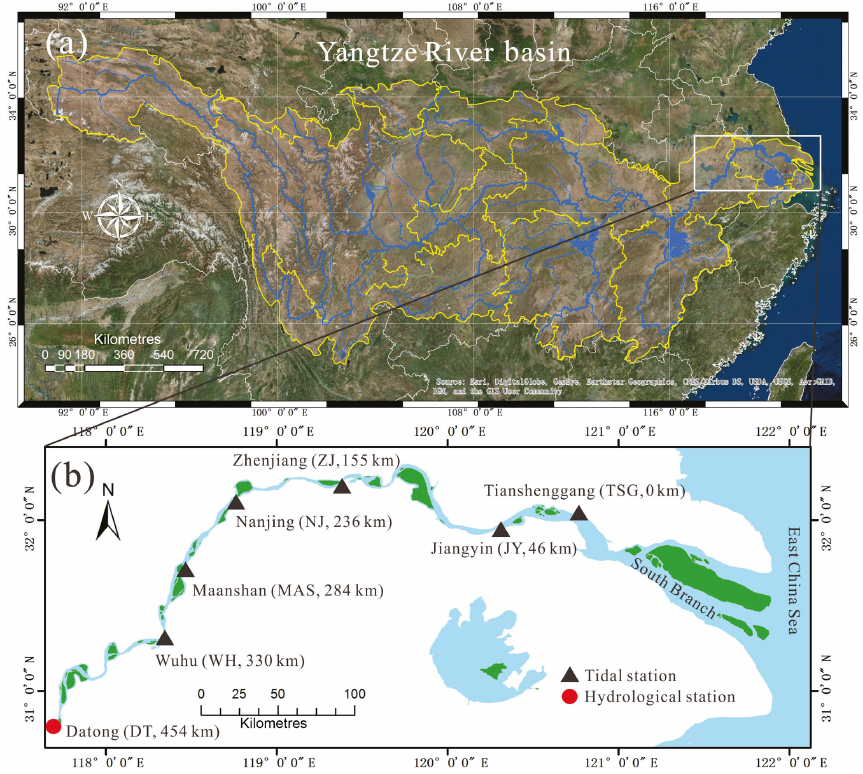
Figure 1. Sketch map of the Yangtze River basin (a) and the Yangtze River estuary (b) displaying the location of gauging (triangle) and hydrological (circle)